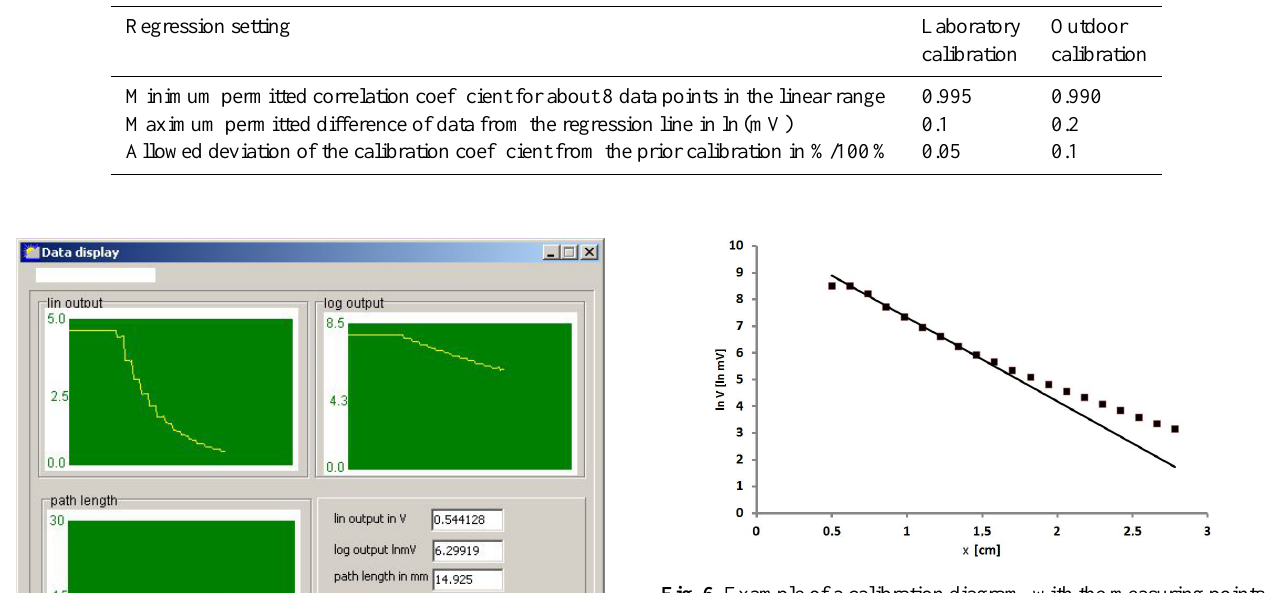
Fig. 6. Example of a calibration diagram, with the measuring points (squares) of the logarithmical output signal in relation to the path length x for nearly constant partial density of water vapour and oxy- gen (note that this appears similar to the original calibration curve from Campbell Scientific, Inc., except that there the abscissa rep- resents the absolute humidity for constant path length), and the re- gression line in the nearly log-linear part of the response function, device KH20 No. 1649, Zwickau, 14 July 2011, ρ w =7.8gm − 3 , ρ o =241gm − 3